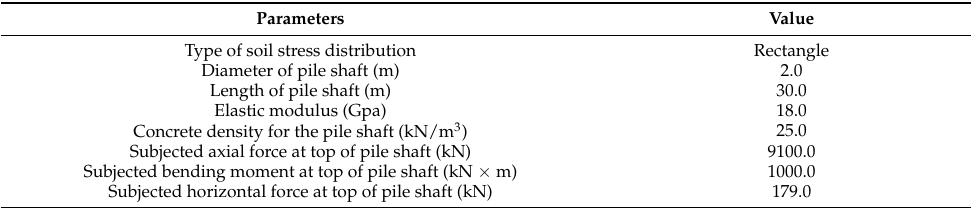
Table 2. Detailed parameters in work of ZHAO et al. [41].